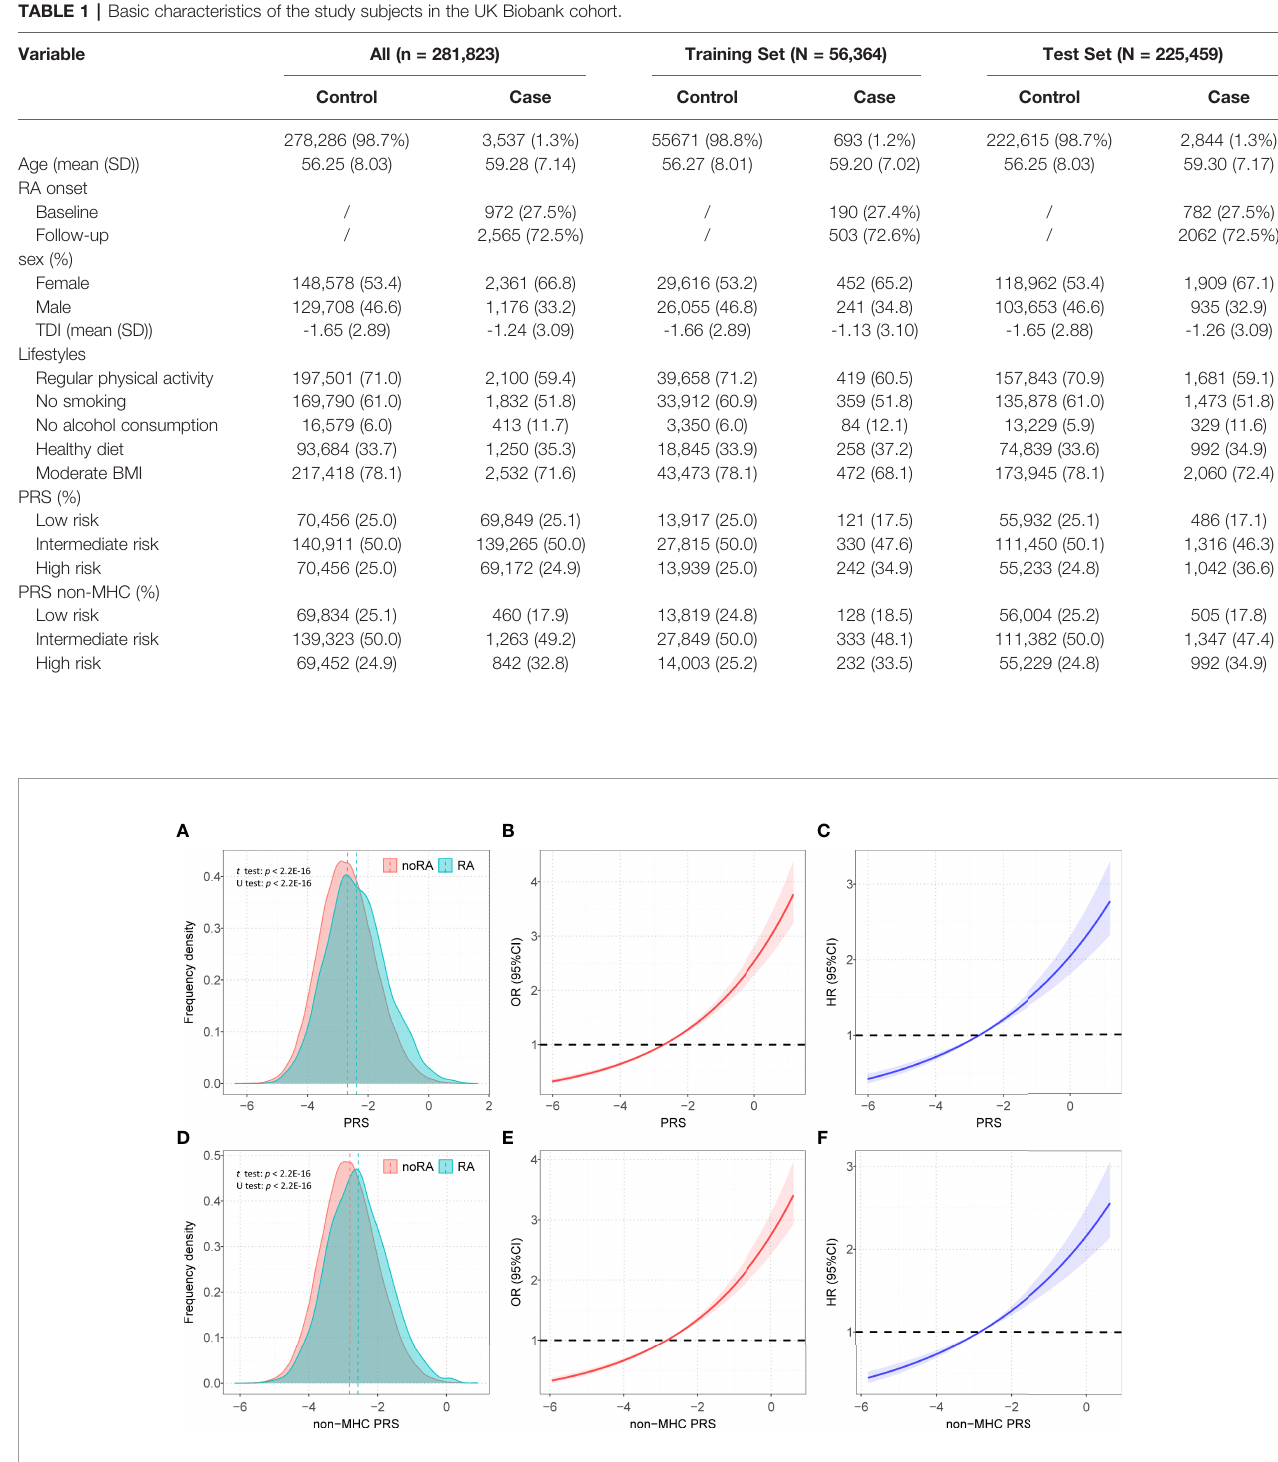
FIGURE 2 | The distributions of PRSs among participants with and without RA. (A) Distribution of PRS among participants with and without RA in all participants; (B) Restricted cubic spline models for the relationship between PRS and RA risk in case – control analysis; (C) Restricted cubic spline models for the relationship between PRS and RA risk in prospective analysis; (D) Distribution of PRS non-MHC among participants with and without RA in all participants; (E) Restricted cubic spline models for the relationship between non-MHC PRS and RA risk in case-control analysis; (F) Restricted cubic spline models for the relationship between non- MHC PRS and RA risk in prospective analysis; Associations in B, C, E, and F were adjusted for age, sex, genotyped batch, assessment center, TDI and the fi rst 10 principal components of ancestry. RA, rheumatoid arthritis; PRS, polygenic risk score; MHC, major histocompatibility complex; OR, odds ratio; HR, hazard ratio.